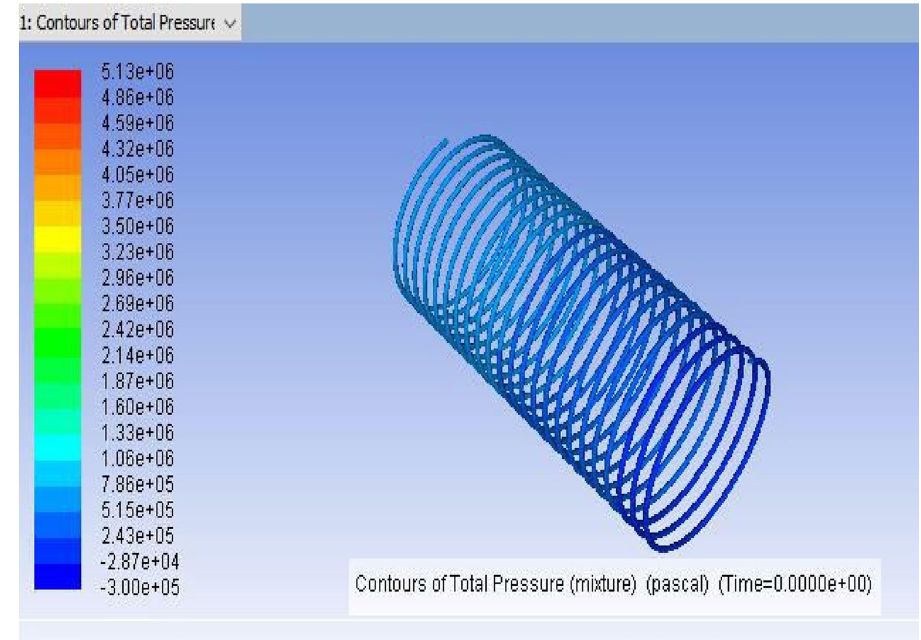
Figure 8. CFD result for a total pressure of Coil-2 (3657.6 mm).